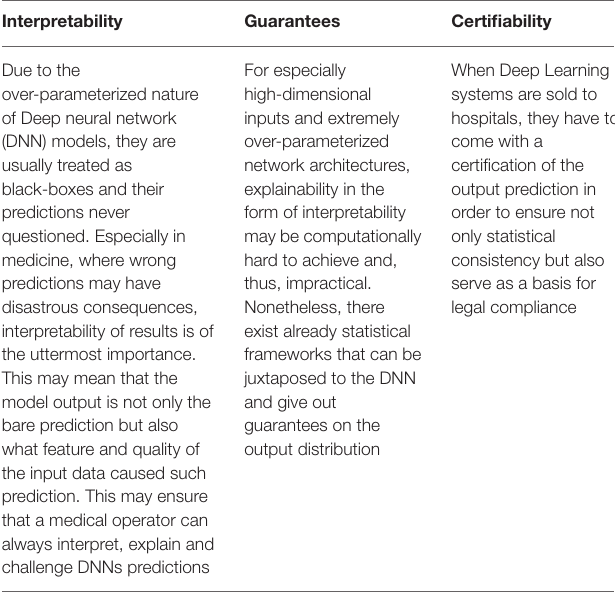
TABLE 1 | Requirements for a suitable use of deep learning in Lung imaging: what the lung ultrasound still lacks. Key messages.